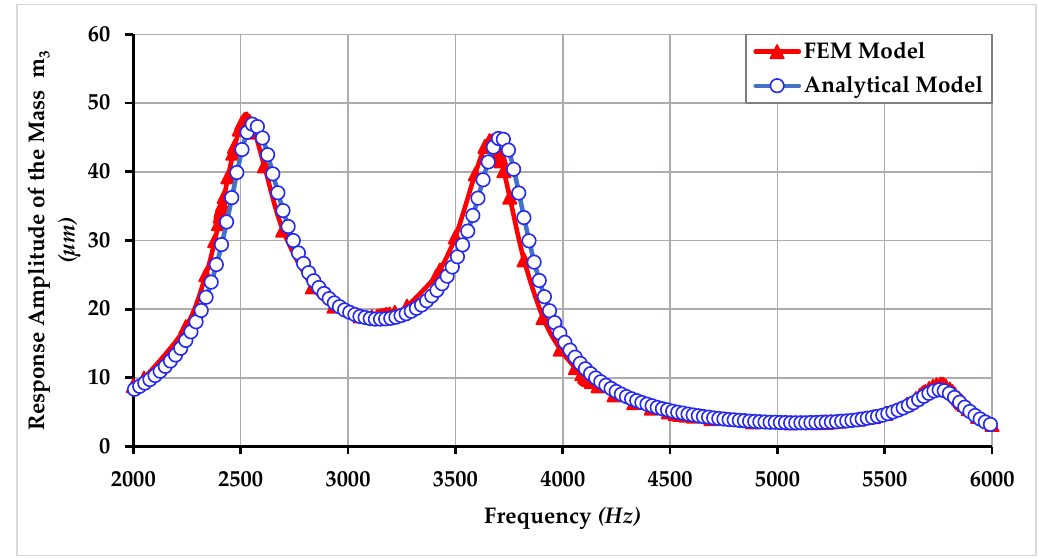
Figure 24. Comparison of response amplitude of the mass 𝑚 3 of the proposed MEMS gyroscope obtained using FEM and an analytical model.